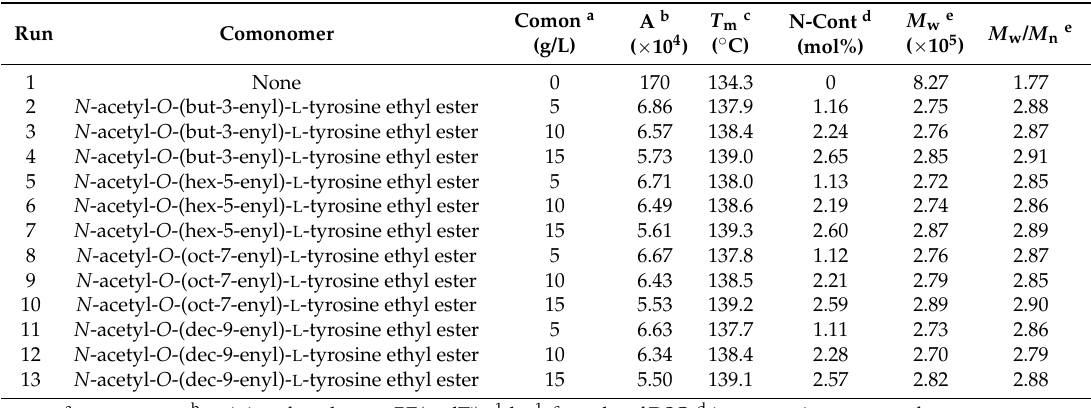
Table 1. Copolymerization of ethylene and N -acetyl- O -( ω -alkenyl)- L -tyrosine ethyl esters with titanium complex.